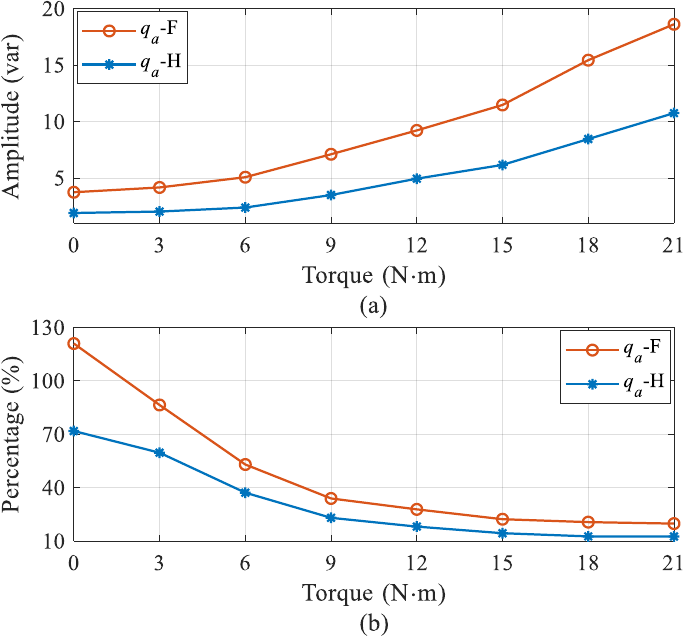
Figure 13. The amplitudes of the second harmonics in IRPs ( a ) and the proposed indicators ( b ), with ITSC, at different torques. ω m was fixed at 400 r/min.